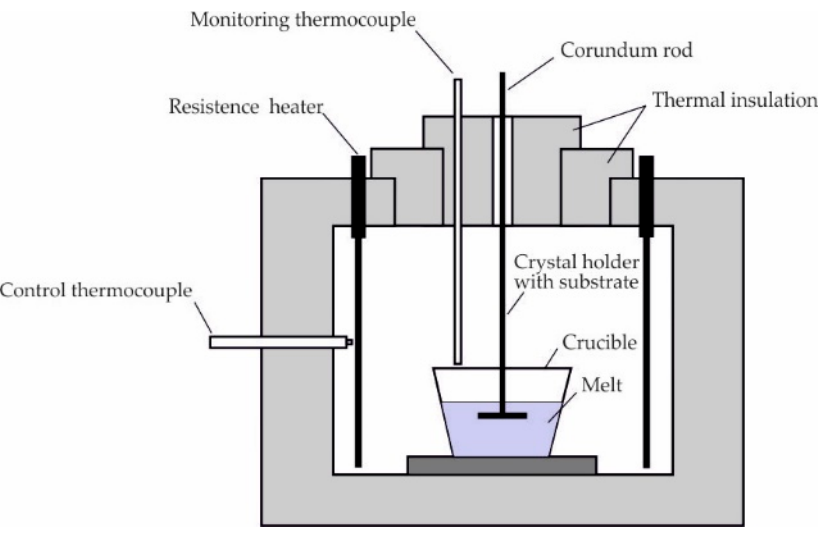
Figure 6. Scheme of the experimental set-up for liquid-phase epitaxy (LPE) [38].